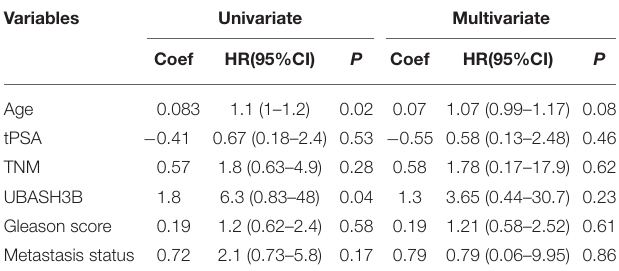
TABLE 2 | Univariate and multivariate regression analysis to determine the independent prognostic factor.